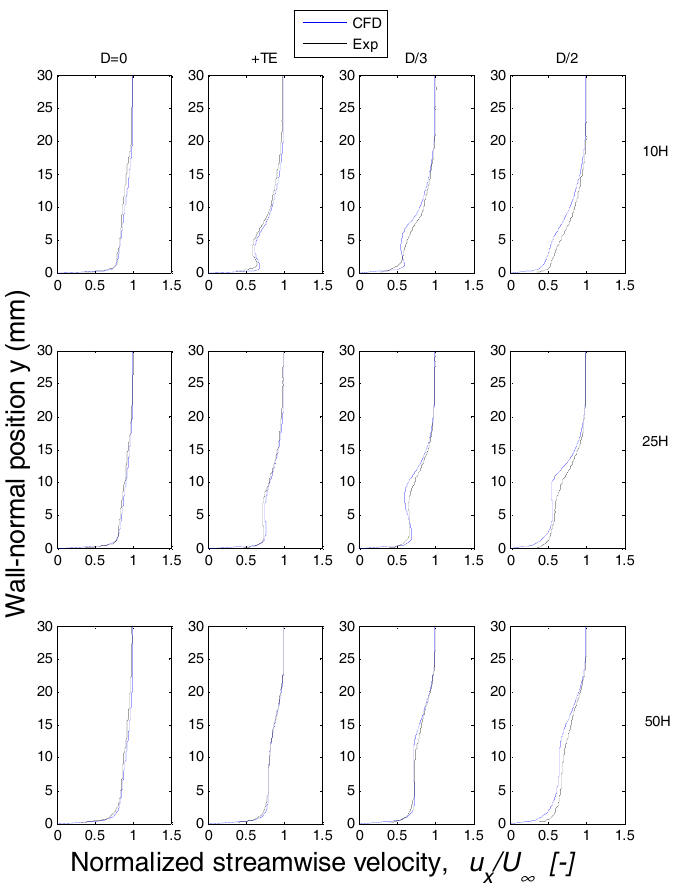
Figure 7. Normalized streamwise velocity profiles () at different streamwise locations 10H (top), 25H (middle) and 50H (bottom) behind the VG. Solid black lines ( – ) correspond to the experimental data and the blue ones ( – ) to numerical profiles.